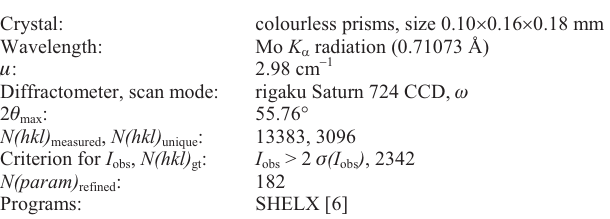
Table 1. Data collection and handling.